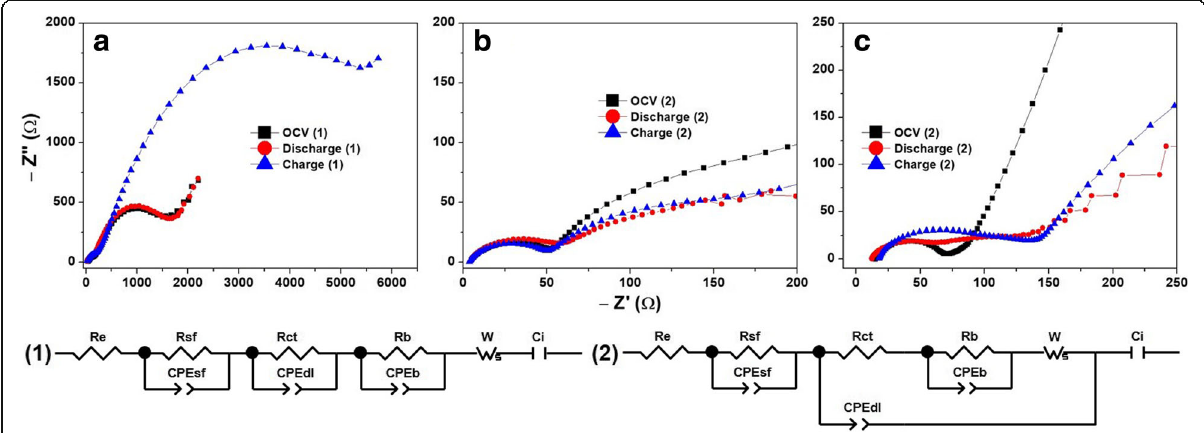
Fig. 9 Li-ion battery impedance analysis of a-VOx films deposited at pO2 ( a ) 6 Pa, ( b ) 13 Pa and ( c ) 30